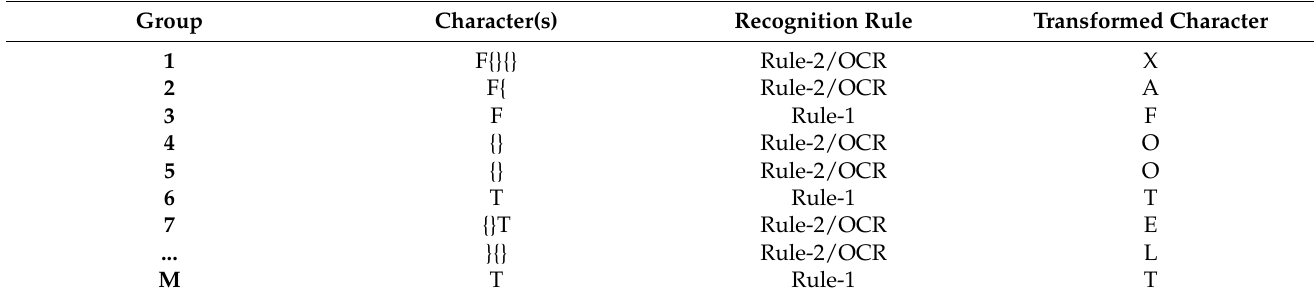
Table 4. An example of Character Transformation.